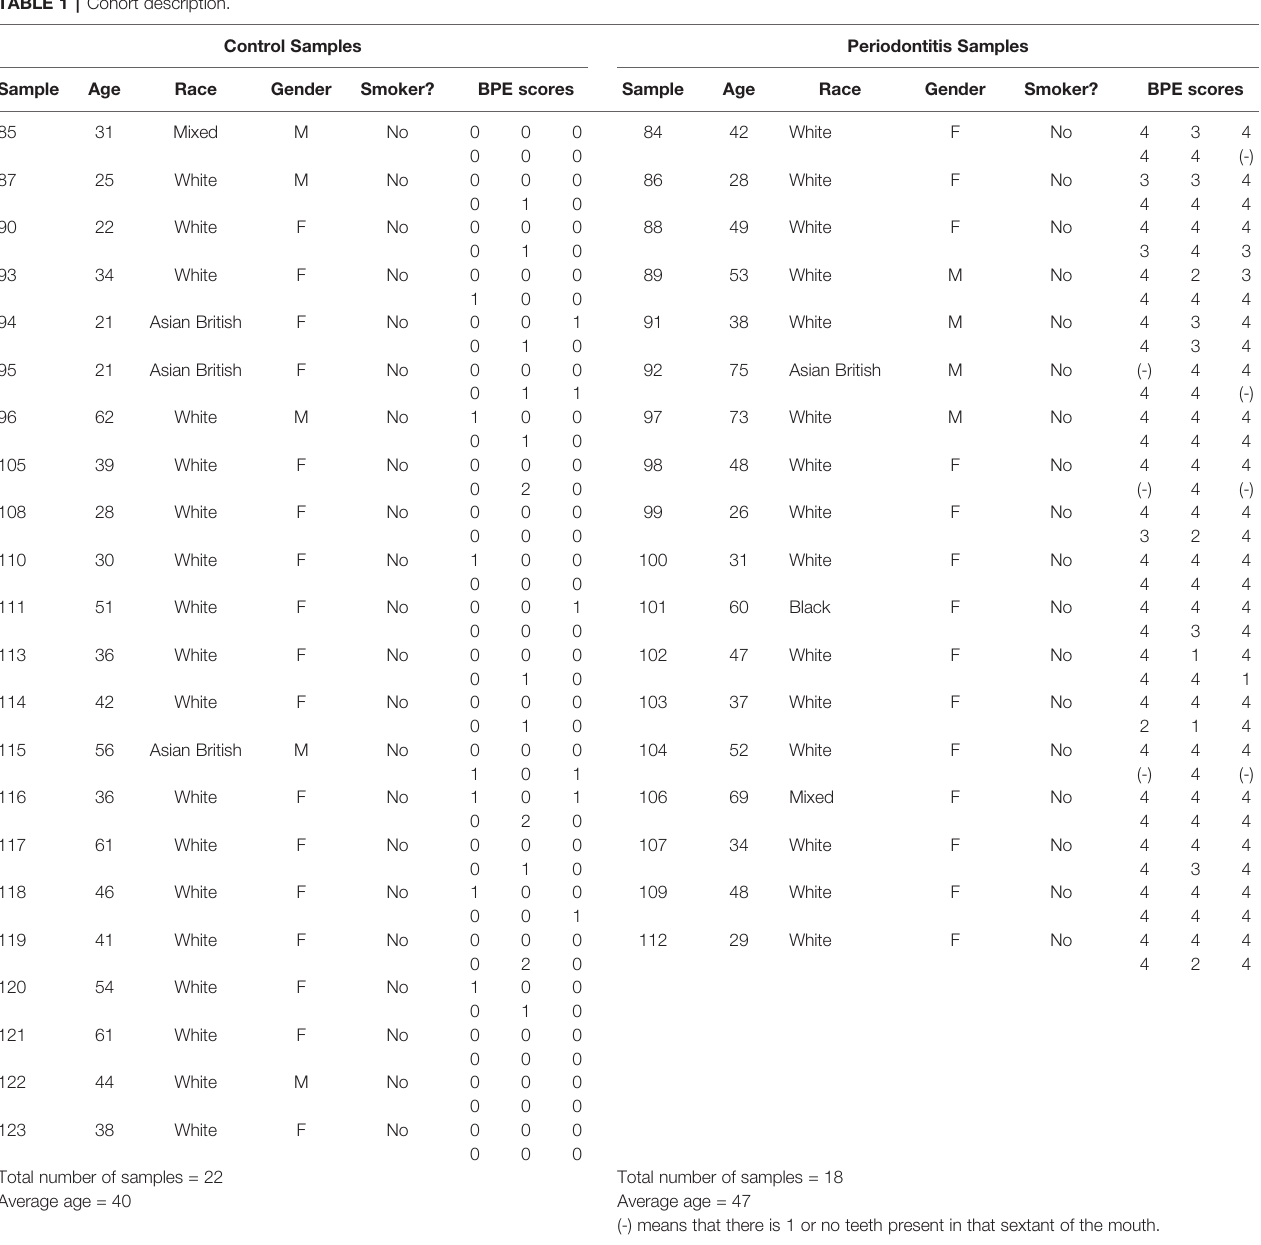
TABLE 1 | Cohort description.